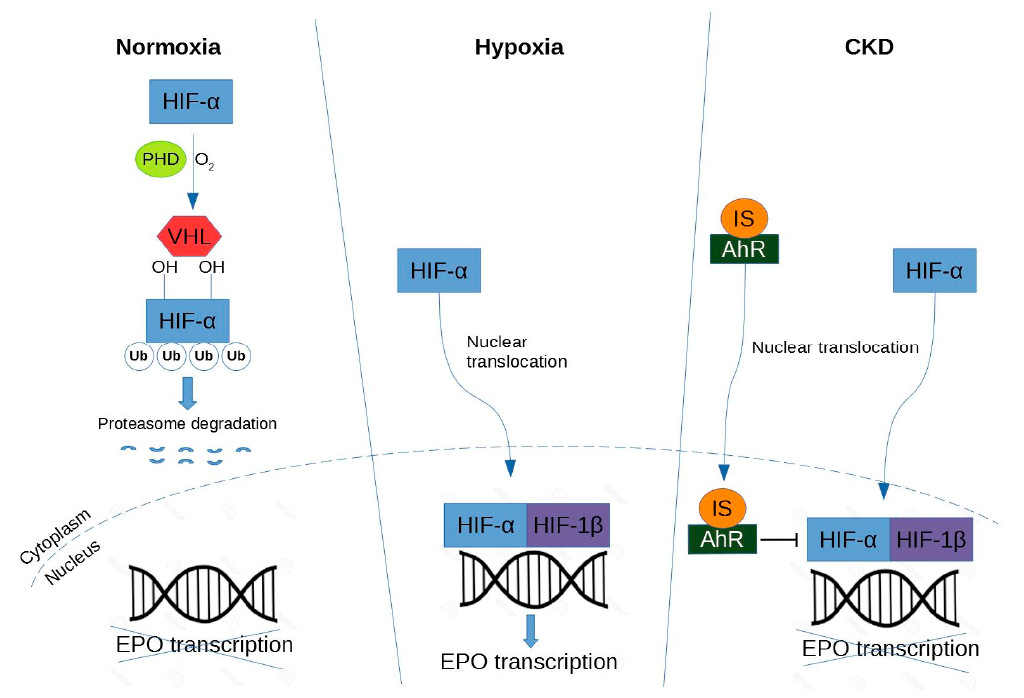
Figure 3. Regulation of hypoxia-inductible factor in renal erythropoietin-producing cells. HIF, hypoxia-inducible factor; PHD, prolyl hydroxylase domain; VHL, von Abbreviations are: HIF, hypoxia-inducible factor; PHD, prolyl hydroxylase domain; VHL, von